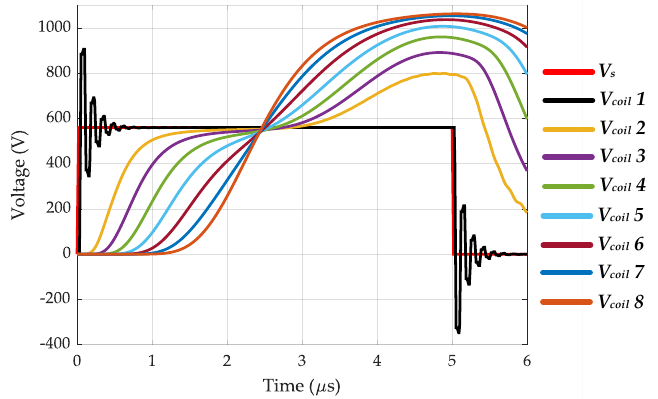
Figure 21. Coil-to-core voltages of different coils when a single-phase model is implemented and is excited by a 560 V PWM voltage with 𝑡 𝑟 = 20 ns and the neutral point is floating.